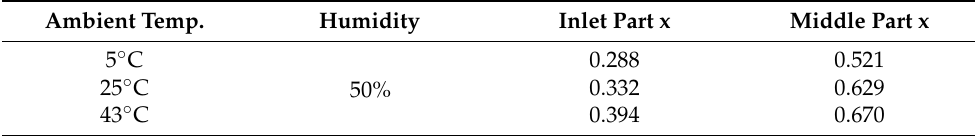
Table 2. Results of visualization experiments in inlet and middle parts of evaporator. Ambient